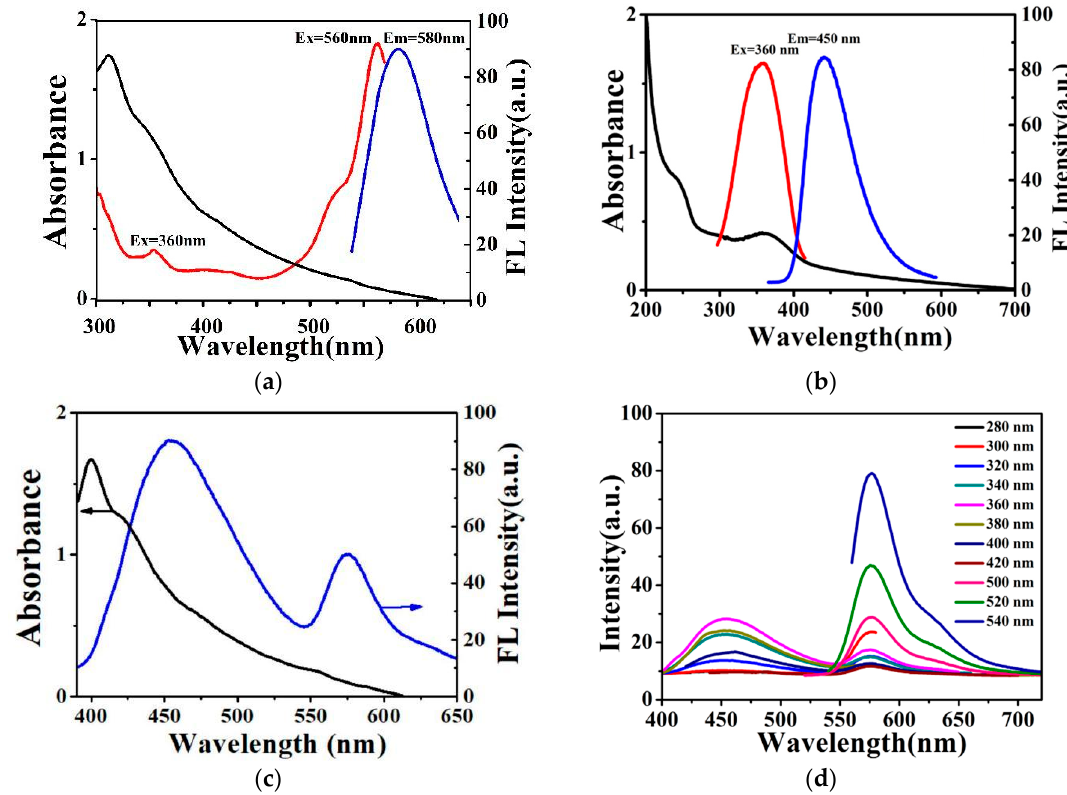
Figure 5. ( a ) Fluorescence spectra (blue line), excitation spectrum (red line), and absorption spectrum (black line) of RBS-doped silica microspheres; ( b ) fluorescence spectra (blue line), excitation spectrum (red line), and absorption spectrum (black line) of CA-AEAPMS; ( c ) fluorescence spectra (blue line) and absorption spectrum (black line) of dual-emission silica microspheres; ( d ) fluorescence spectra at different excitation wavelengths of dual-emission silica microspheres.